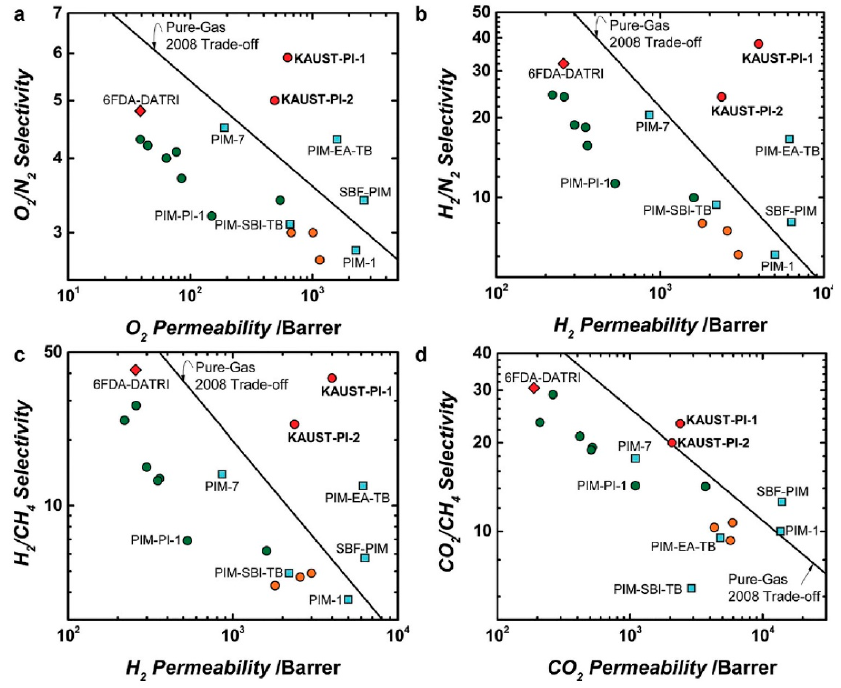
Figure 7. Separation performance for ( a ) O 2 /N 2 , ( b ) H 2 /N 2 , ( c ) H 2 /CH 4 , and ( d ) CO 2 /CH 4 gas pairs showing data for KAUST-PI-1 and KAUST-PI-2. Symbols represent notable materials from various classes including = Ladder PIMs, = Extended and = Non-extended PIM-PIs (Extended PIM-PIs means the reactive anhydride was grafted on the dibenzodioxin units by the introduction of 4,5-dichlorophthalonitrile instead of on the 1,1-spirobisindane unit, while, in the non-extended PIM-PIs, anhydride groups are fused directly to the 1,1-spirobisindane unit [61,62]). Solid lines represent state-of-the-art 2008 permeability/selectivity upper bounds. Reproduced from Reference [34].